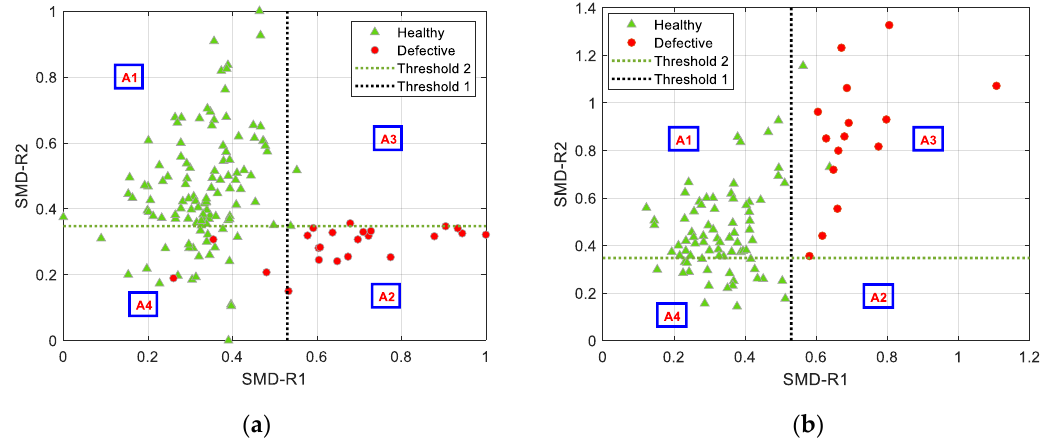
Figure 8. ( a ) Classification on the training dataset; ( b ) classification on the testing dataset. Table 3. Classification performance of 𝐈𝐌𝐂𝐒 𝐏𝐒𝐎𝐁𝐏𝐒𝐎 over 20 independent runs using a reference MD space based on both healthy and defective samples